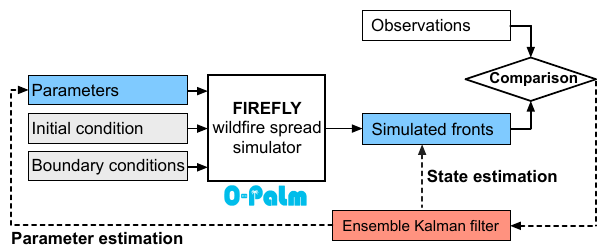
Figure 1. Data assimilation flowchart for PE and SE approaches over one assimilation cycle (control variables are colored in blue) using OpenPALM. Note that the SE approach provides the correc- tion of the fire front location at the observation time and not at the initial time of the current assimilation